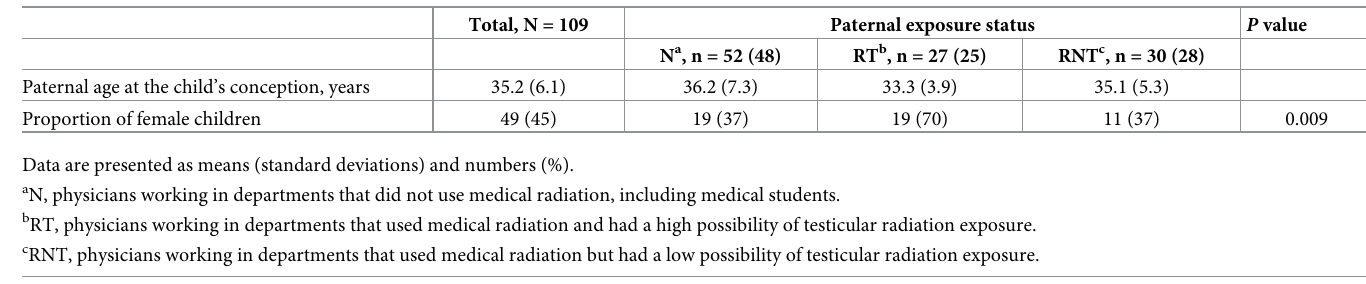
Table 1. Paternal age at the child’s conception and the proportion of female